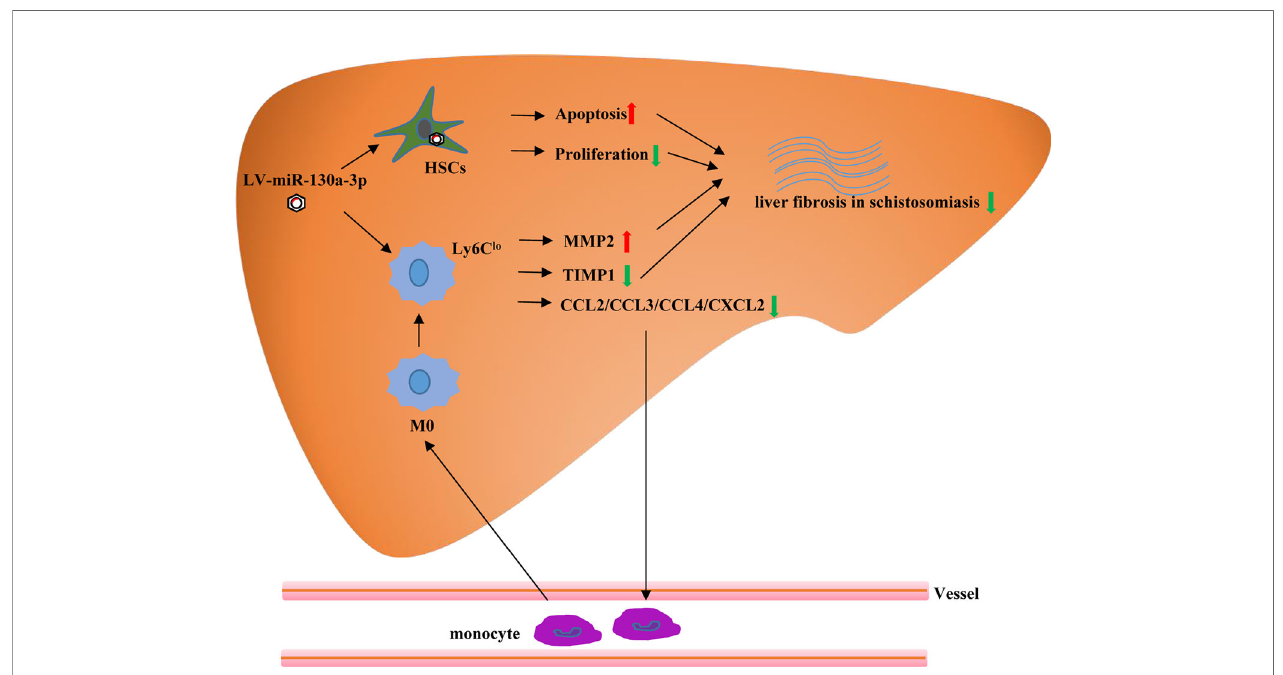
FIGURE 8 | The graphical abstract of probable cellular and molecular mechanisms by which miR-130a-3p delivery mitigates liver fi brosis of schistosomiasis. Overexpression of miR-130a-3p increases HSC apoptosis and reduces proliferation and activation of HSCs. Moreover, miR-130a-3p could also upregulate the expression of Ly6C lo macrophages, concomitant with decreased expression of TIMP1, and increased expression of MMP2, contributing to the dissolution of